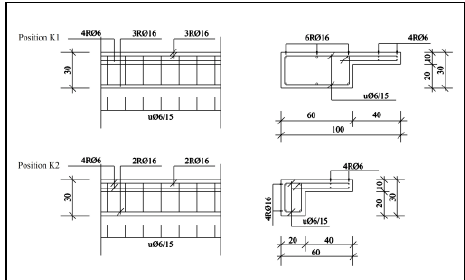
Figure 36. Plan of floor attic reinforcing. Figure 37. RC cornices with stone slabs.